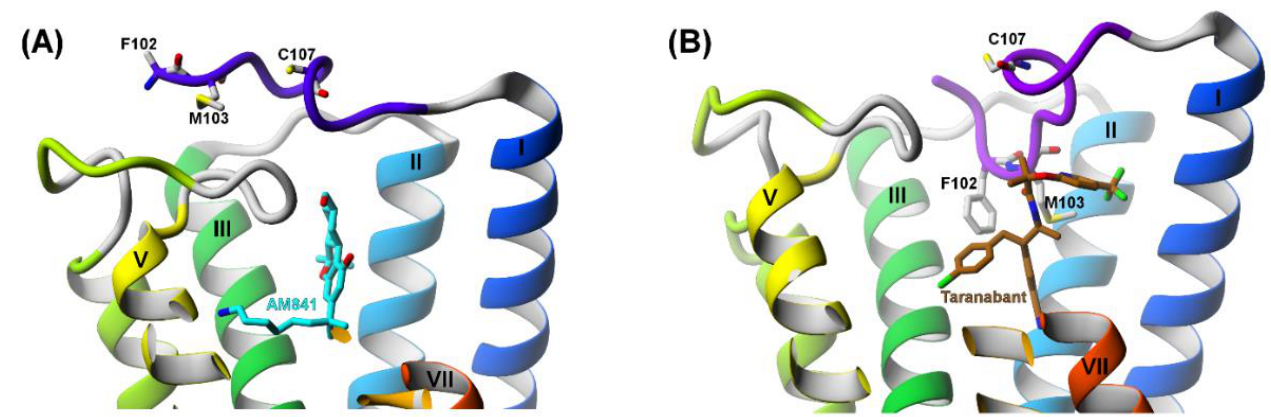
Figure 5. The influence of C98–C107 disulfide bond on the orthosteric binding of CB 1 R. ( A ) PDB id:5XR8 structure with no disulfide bond; ( B ) PDB id:5U09 structure with disulfide bond present. In 5XR8 structure the residues F102 and M103 are outside of the orthosteric binding site; the ligand’s position is shallower and there is much more space available in the orthosteric binding site so the ligand has more freedom and is in contact with many water molecules. In 5U09 structure the residues F102 and M103 are inside the orthosteric binding site; the ligand is positioned deeper, surrounded by hydrophobic residues and the binding is